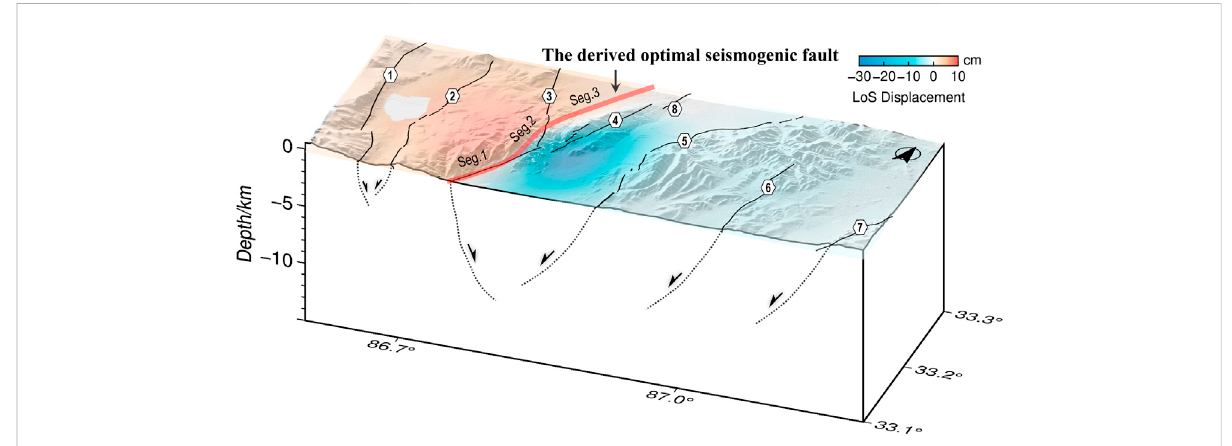
FIGURE 12 3DstructureoftheactivenormalfaultsintheYibu-Chakagrabenandthederivedoptimalseismogenicfaultofthe2020Nimaearthquake.Black lines in the section indicate normal faulting. Caption is as for Figures 2,